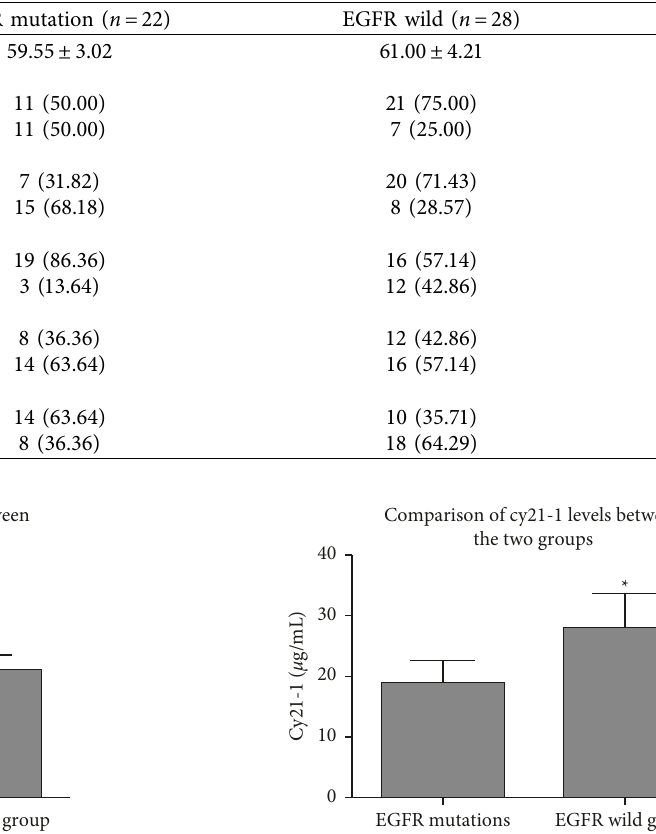
Table 2: Relationship between the EGFR gene status and clinicopathological characteristics of patients.